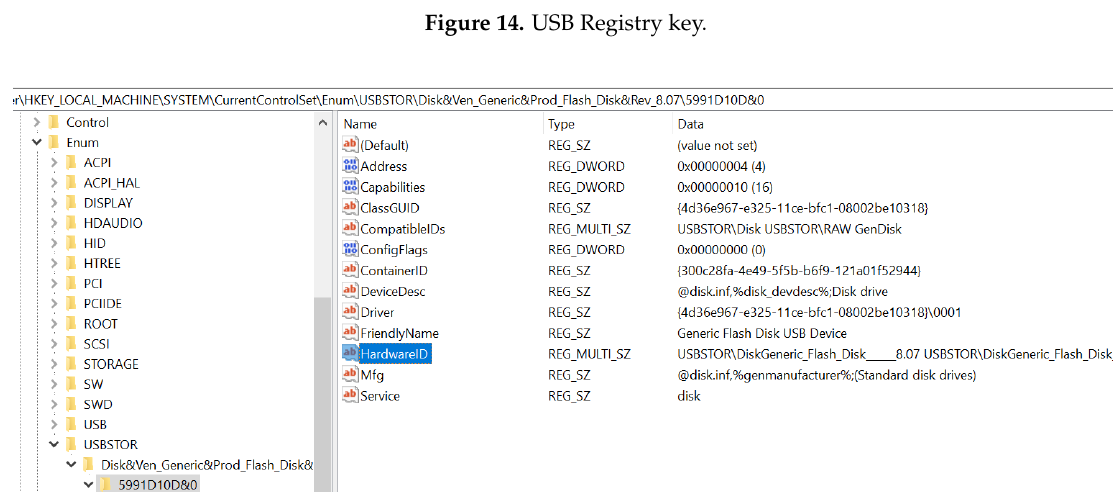
Figure 15. USBSTOR registry key